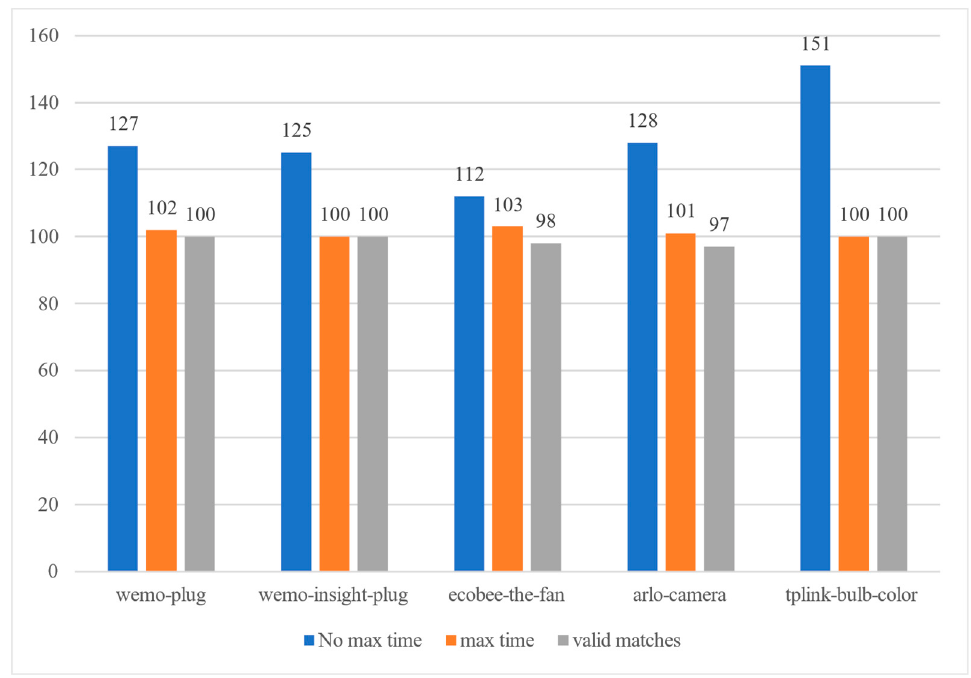
Figure 10. Event detection experiment.